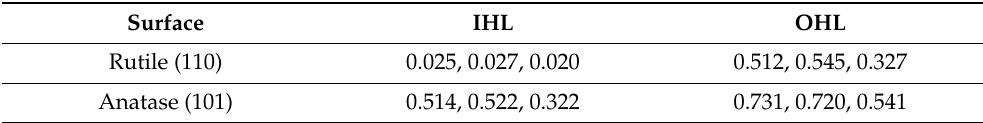
Table 2. Self-diffusivities [ × 10 − 9 m 2 s − 1 ] ( x , y , z ) in adsorbed layer (IHL) and second layer (OHL) from each surface. The total self-diffusivity is given by the sum of the different laboratory directions. Surface